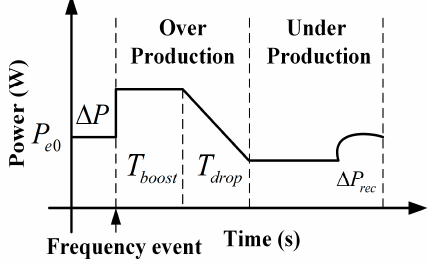
Figure 9. Fast power reserve characteristics.